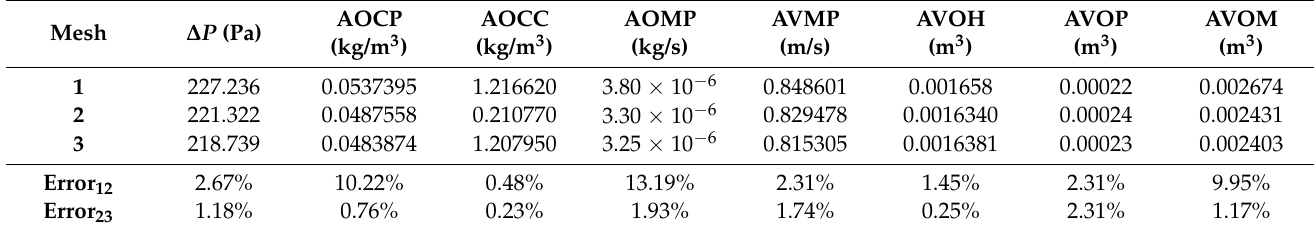
Table 7. Operational parameters used in the mesh study.